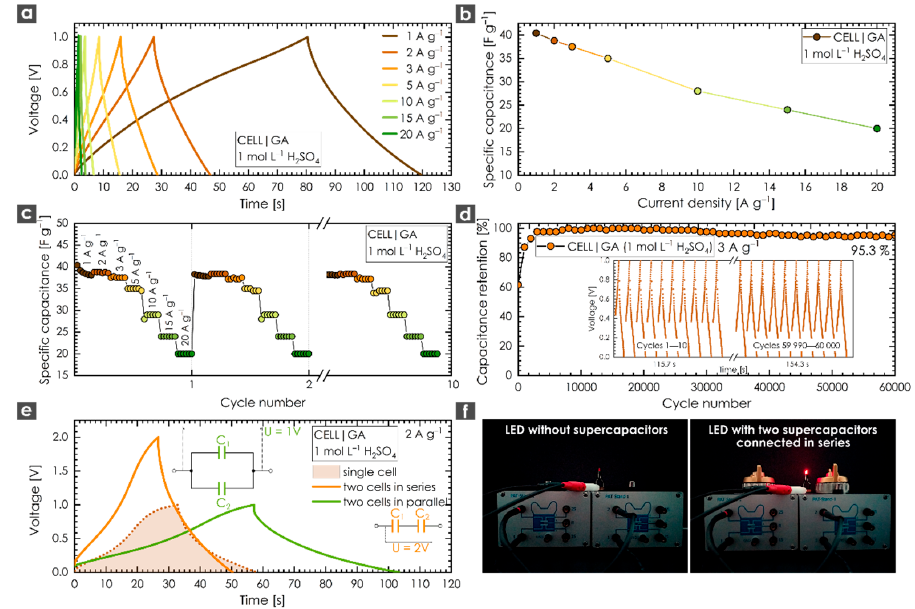
Figure 4. ( a ) GCD response of GA in a two-electrode configuration recorded at current densities ranging from 1 to 20 A g − 1 ; ( b ) decrease in the specific capacitance of GA with increasing current density; ( c ) rate stability test of GA recorded at current densities ranging from 1 to 20 A g − 1 ; ( d ) cycling stability of GA after 60,000 cycles; inset shows first and last 10 cycles in a potential di ff erence of 1 V (recorded from − 0.35 V to 0.65 V); ( e ) response of two supercapacitor cells equipped with GA connected in series or in parallel; ( f ) LED test of two supercapacitor cells equipped with GA connected in series. All measurements were performed in 1 mol L − 1 H 2 SO 4